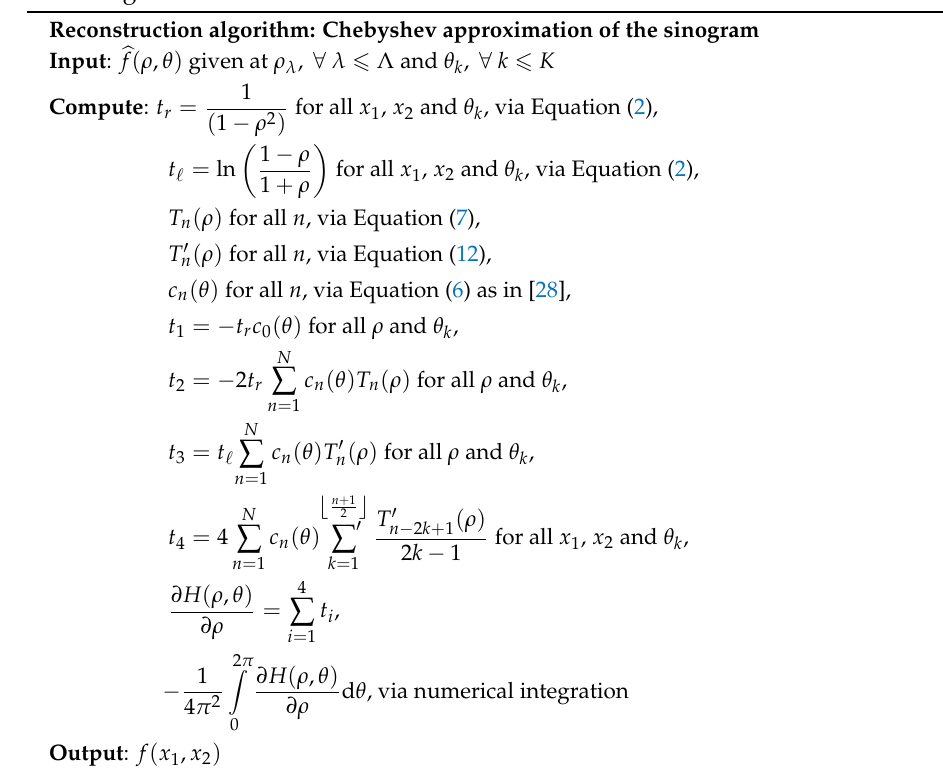
Algorithm 1: Computational steps of the proposed Chebyshev-based reconstruc- tion